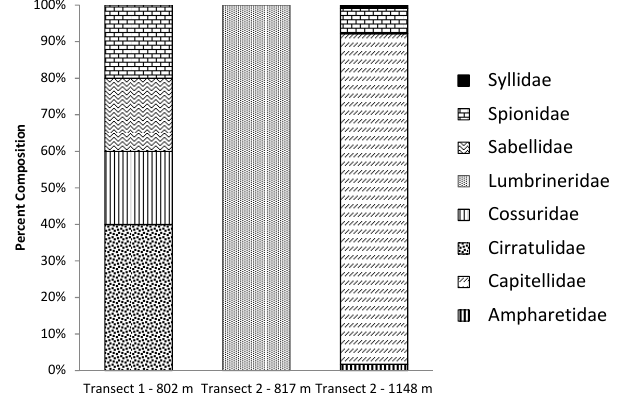
Fig. 6. Annelid family composition in colonization trays on the W. Indian margin. See Table 1 for tray deployment periods and loca-